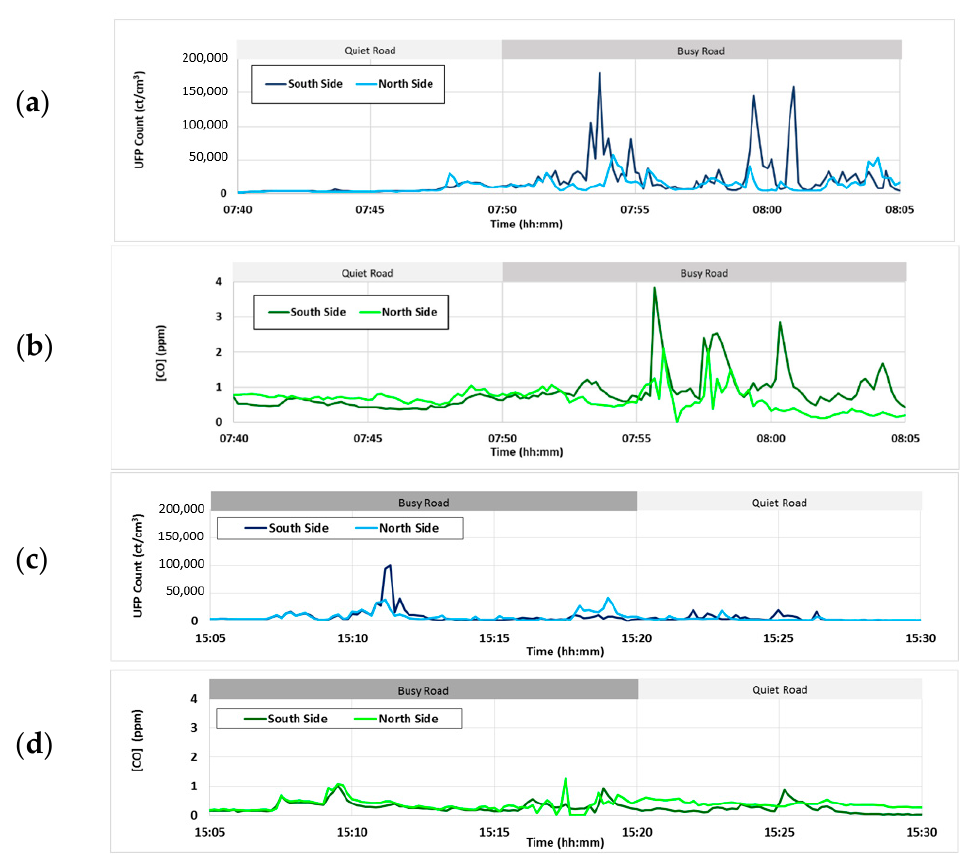
Figure 3. Example time series of exposure during the morning Walking School Bus (WSB) for ( a ) UFP (ultrafine particle) and ( b ) CO and the afternoon ( c ) UFP and ( d ) CO. The participant walking on the north side of the street (high traffic side during the morning rush hour and low in the afternoon) is shown in the darker color.